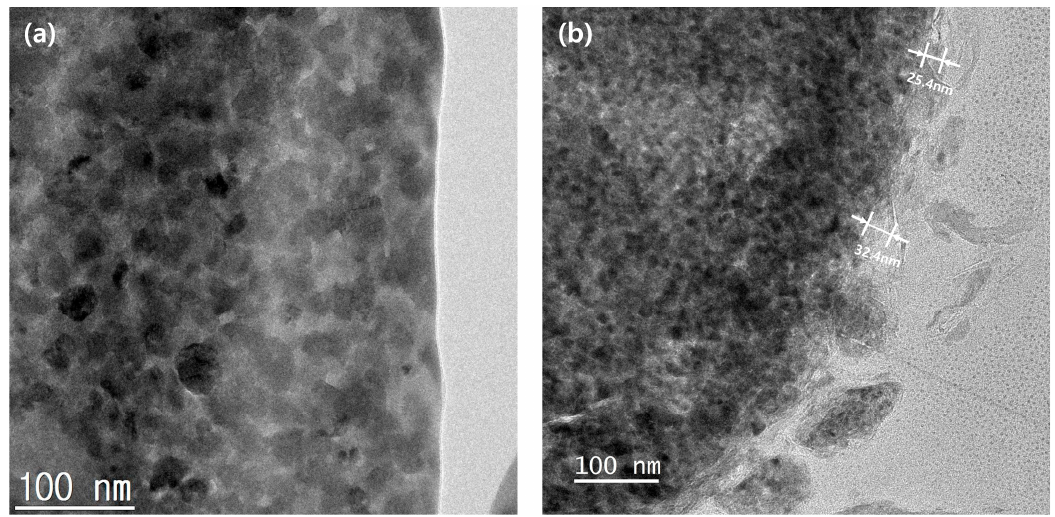
Figure 7. Cross-sectional TEM images of the powder surfaces: ( a ) N-Si alloy and ( b ) Al 2 O 3 -2.